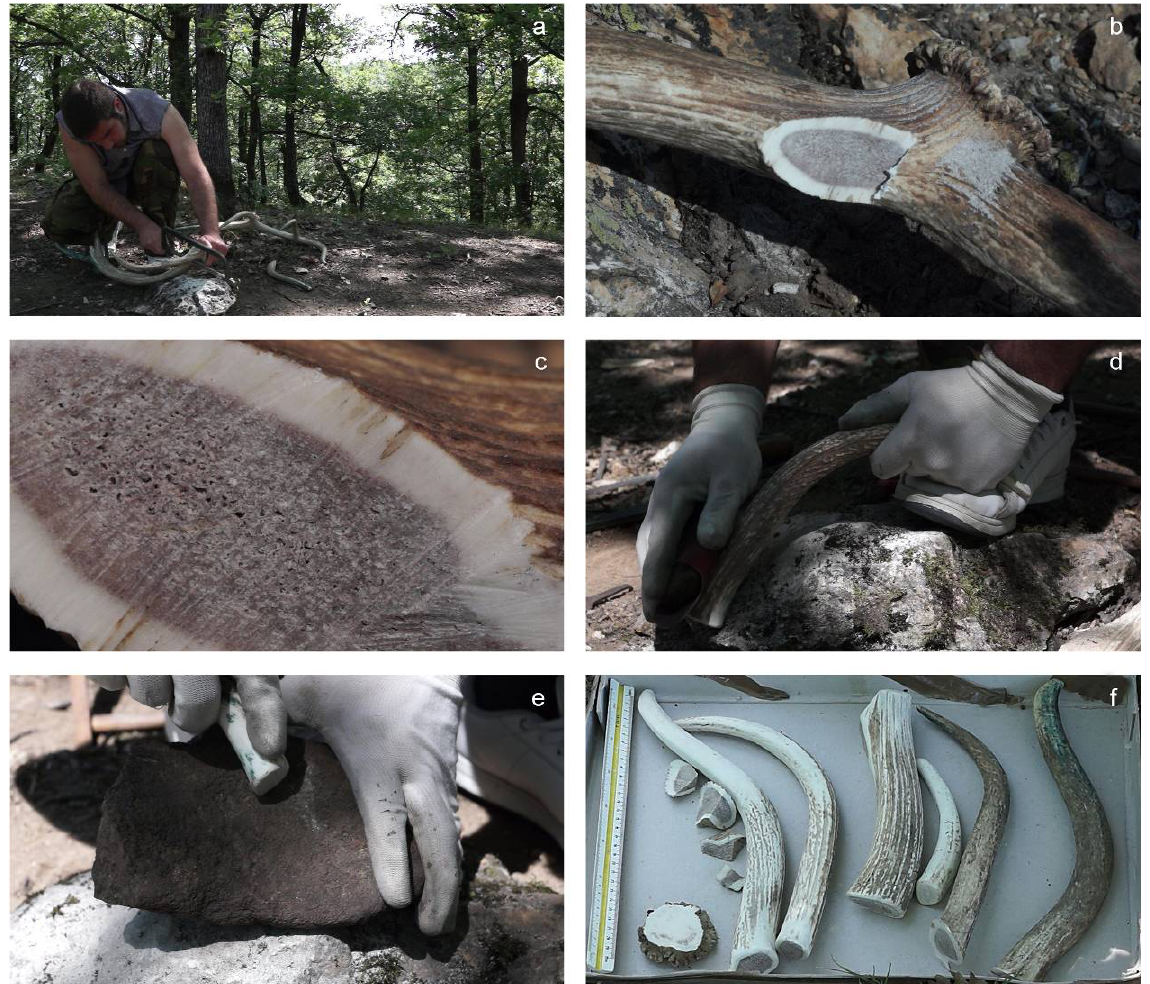
Figure 4. Basic phases of processing bone tools and products of